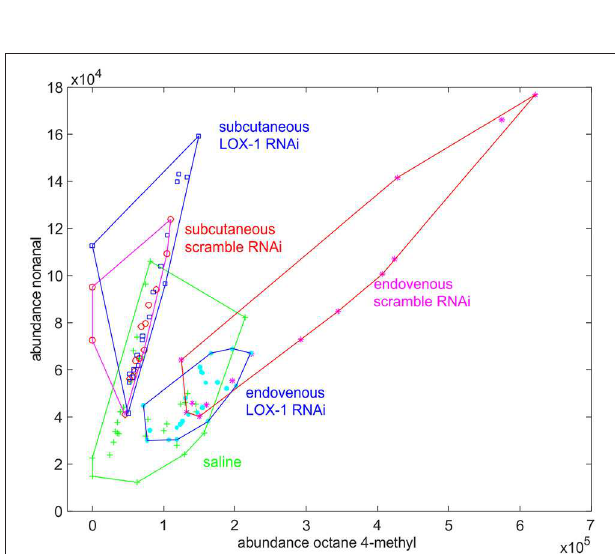
FIGURE 5 | Plot of the abundance of nonanal vs. the abundance of octane-4-methyl found in mice volatilome. In each group the data collected along the whole experiments are plotted. While the abundance of nonanal is a specific of experimental condition, the abundance of octane-4-methyl is larger in mice endovenously injected with scramble RNAi